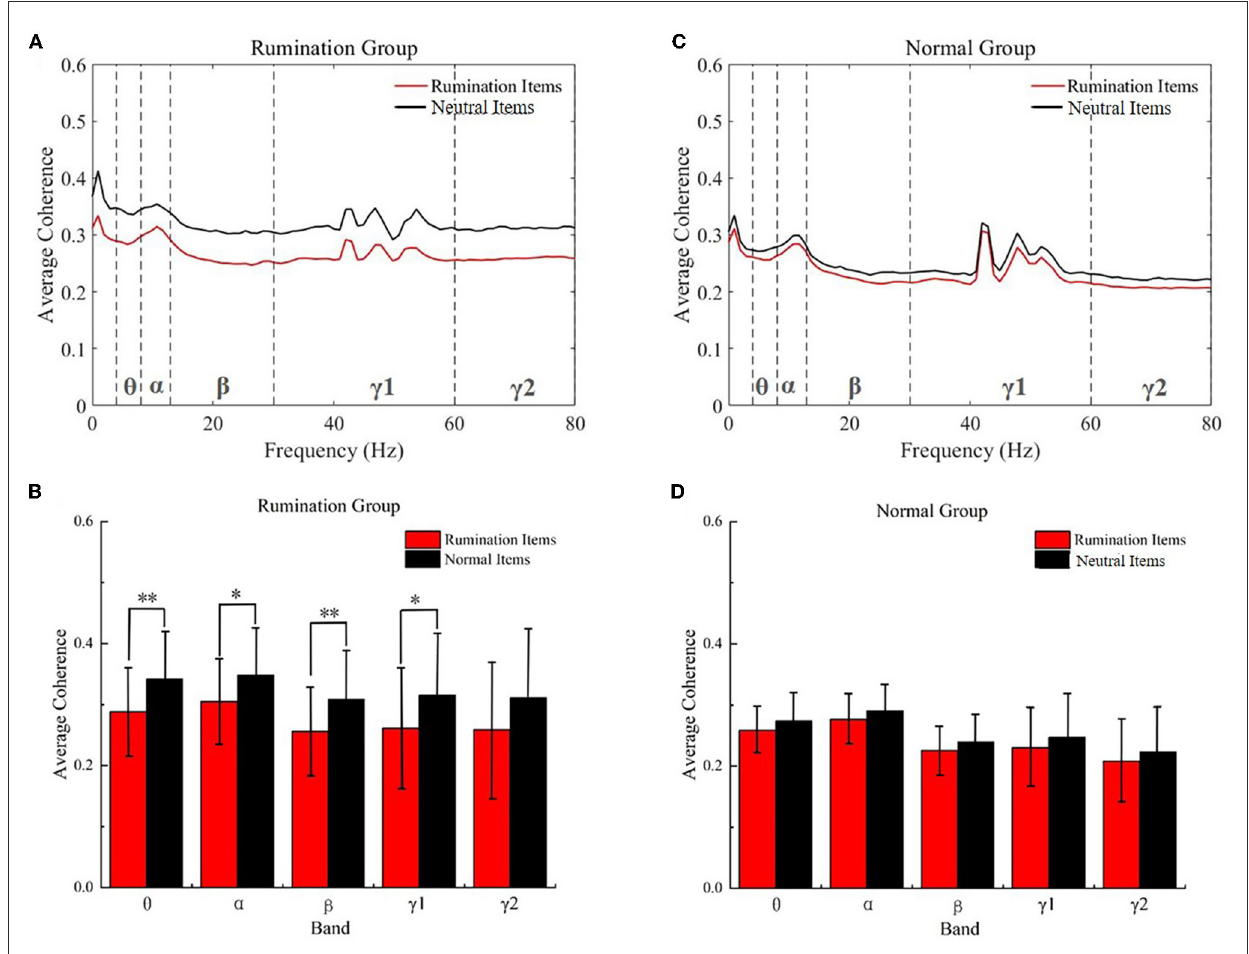
FIGURE3 Within the group coherence analysis, the subjects completed the rumination items and neutral items. (A) Average coherence of all frequency bands in the rumination group. (B) Average coherence for the five frequency bands in the rumination group. (C) Average coherence of all frequency bands in the controls. (D) Average coherence in the five frequency bands in the controls. * p < 0.01, ** p < 0.001. Red, rumination items; black, neutral items; Normal Groups means control